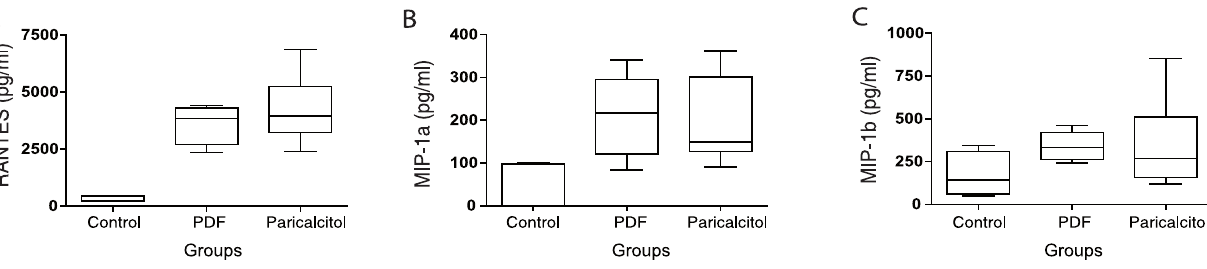
Figure 5. Chemokine concentrations in the peritoneal cavity were not affected by paricalcitol treatment. Concentrations of RANTES (A), MIP-1 a (B) and MIP-1 b (C) were determined in the peritoneal washing fluid. We observed no difference between the paricalcitol and the PDF